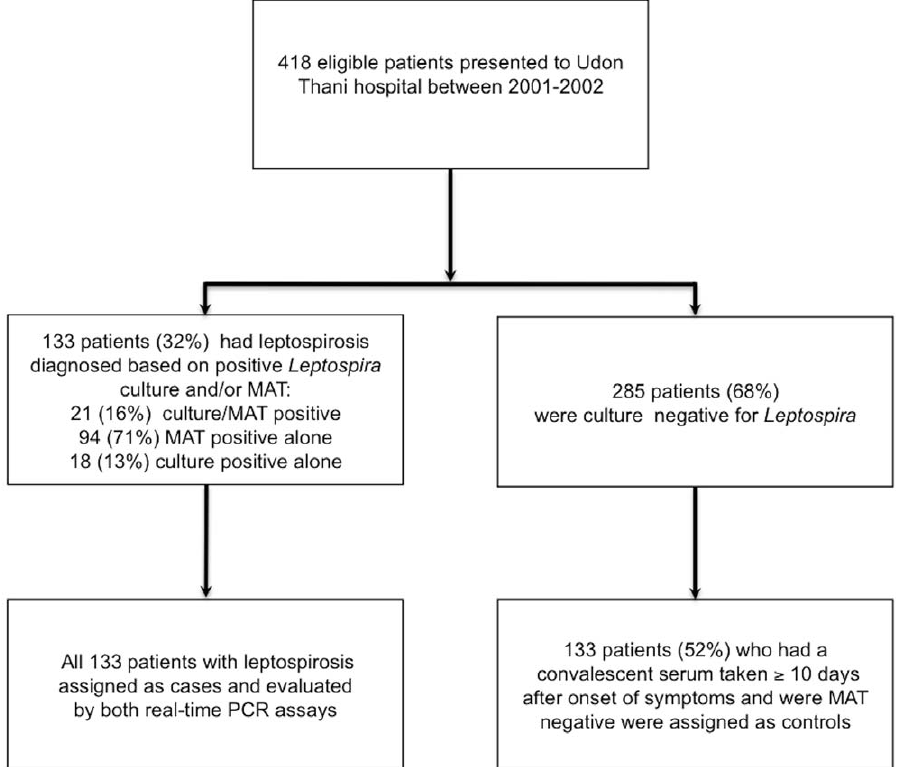
Figure 1. Study design and patient recruitment.